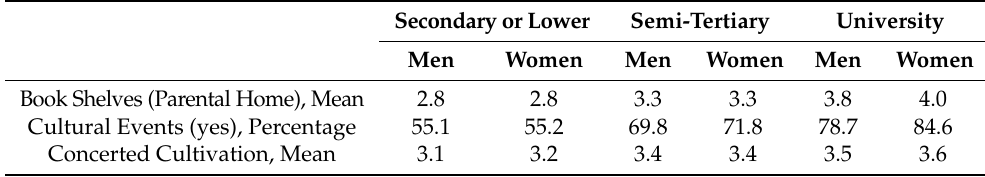
Table 2. Parents’ cultural capital and educational attainment of children by gender.